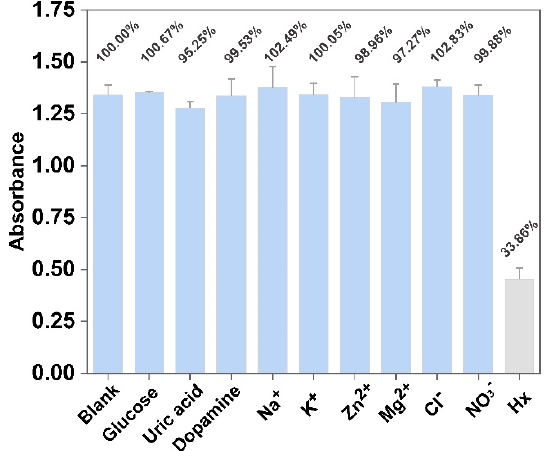
Figure 6. Peak absorption values of the sensing system in the absence and presence of glucose, uric acid, dopamine, Na + , K + , Zn 2+ , Mg 2+ , Cl − , NO 3 − , and Hx, respectively. The concentration of Hx was 1 mM, while other non-target species is 5 mM. Error bars were obtained from three repetitive experiments.